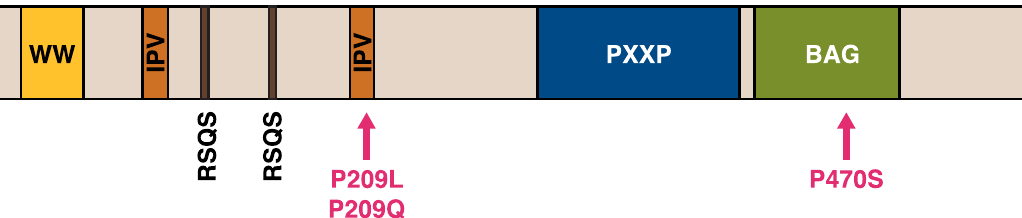
Figure 6. Schematic structure of BAG3 with domains and motifs, and myopathy-causing mutations indicated. BAG3: Bcl-2-associated athanogene 3, or BAG family molecular chaperone regulator 3.